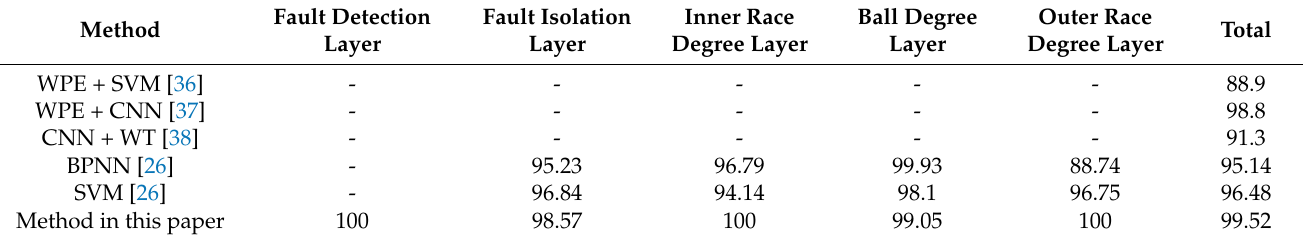
Table 6. Comparison with other methods.